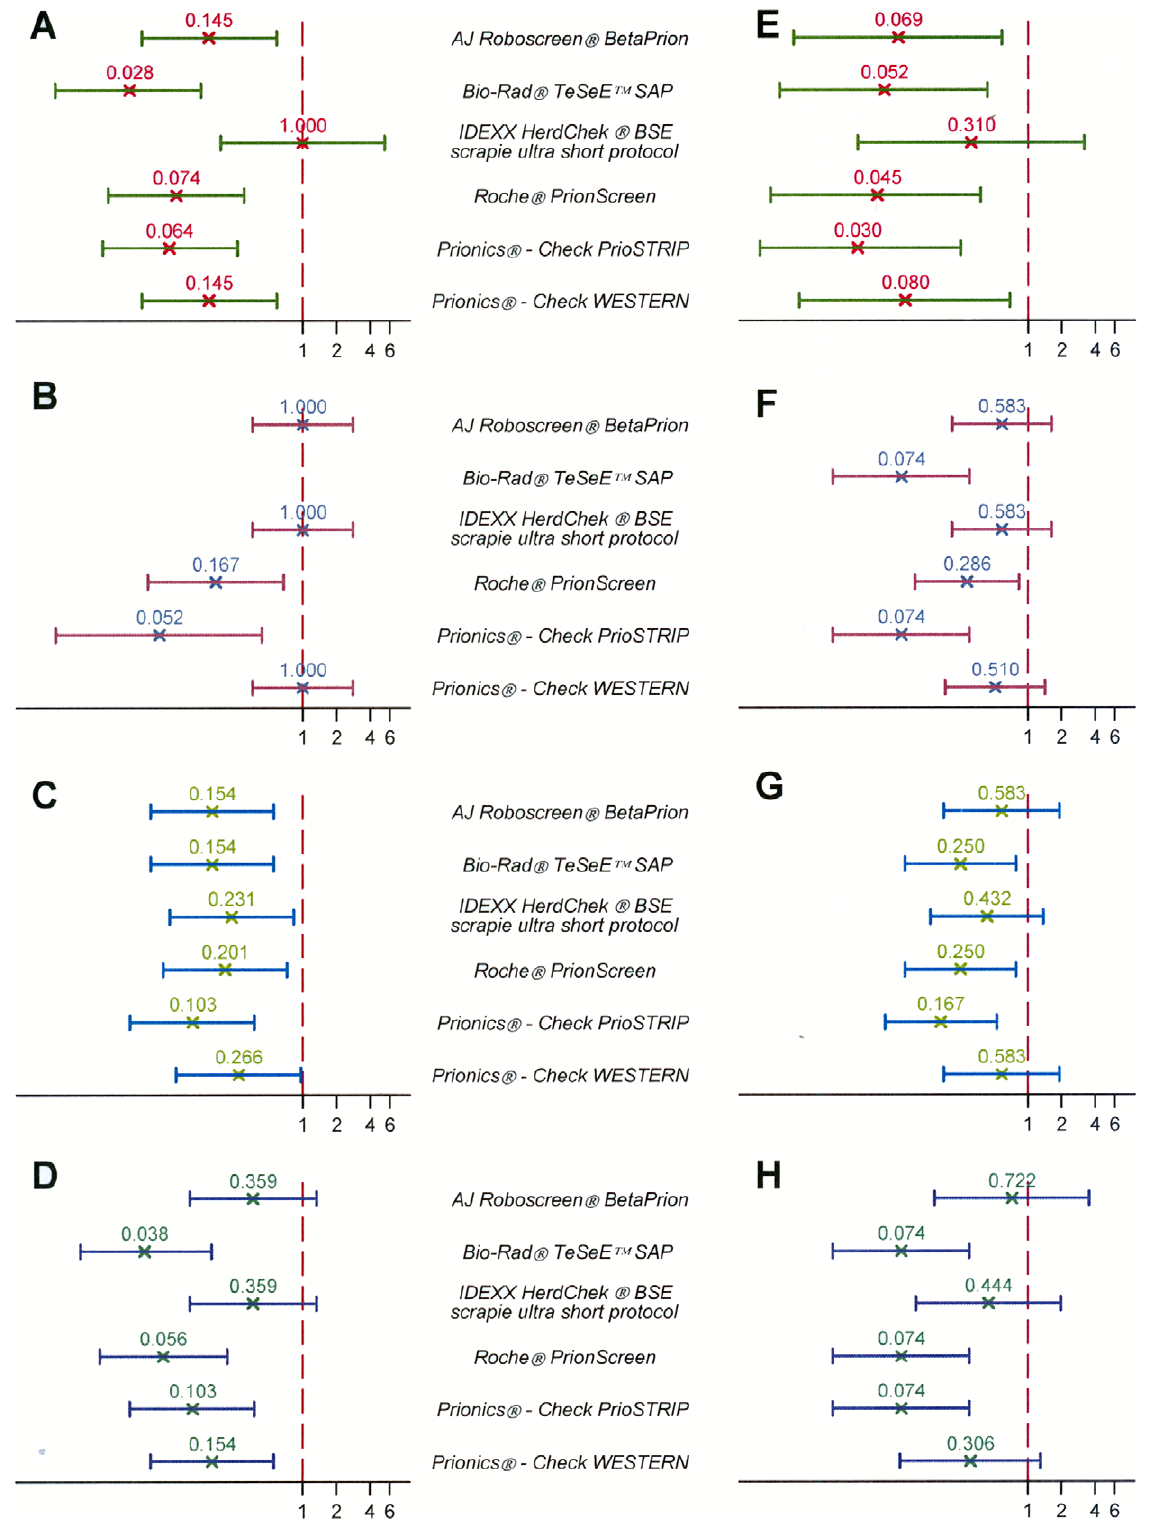
Figure 1. Test performance compared to the IDEXX H HerdCheckBSE-scrapieshortprotocol . The vertical axis reports the different rapid tests challenged. The horizontal axis reflects the odds ratio magnitude using IDEXX H HerdCheck BSE-scrapie short protocol as reference test. Panels A, B, C, D (left column) report the results obtained under the w/v protocol; panels E, F, G, H (right column) display the results under the manufacturers’ instructions. BSE forms studied: panels A, E: strong C-type; panels B, F: weak C-type; panels C, G: H-type; panels D, H: L-type. All the weak C type water dilutions series tested negative with Bio-Rad H TeSeE TM SAP (notably, the optical densities were for all the three replicates of the 1:2 dilution just under the cut-off value), thereby, the odd ratio could not be calculated (Subfigure B). doi:10.1371/journal.pone.0043133.g001 PLOS ONE |